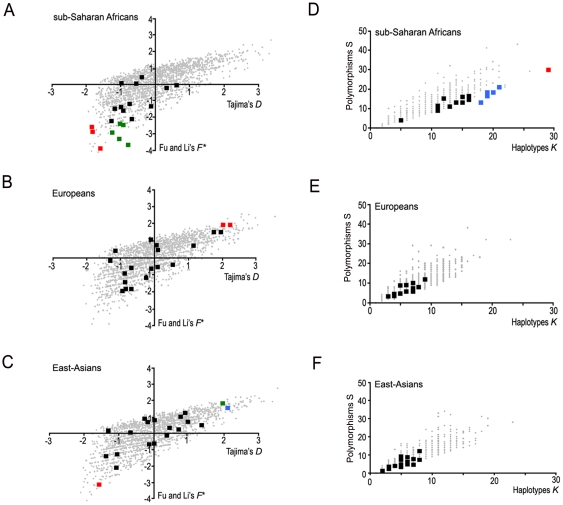
Sequenced-based summary statistics in Africans, Europeans and East-Asians.Biplots of Tajima's D and Fu and Li's F* computed for each genomic region separately, in Africans (A), Europeans (B) and East-Asians (C). Significant Tajima's D values (P<0.05) are indicated in blue, in green for Fu and Li's F* only, and in red for both. Biplots of the number of haplotypes (K) and polymorphisms (S) computed for each genomic region separately in Africans (D), Europeans (E) and East-Asians (F). Significant K values (P<0.05) are indicated in blue, in green for S, and in red for both. The grey dots indicate the expected values of each genomic region simulated assuming a constant population size model (simulation procedure and significance of each region are described in the Materials and Methods section).